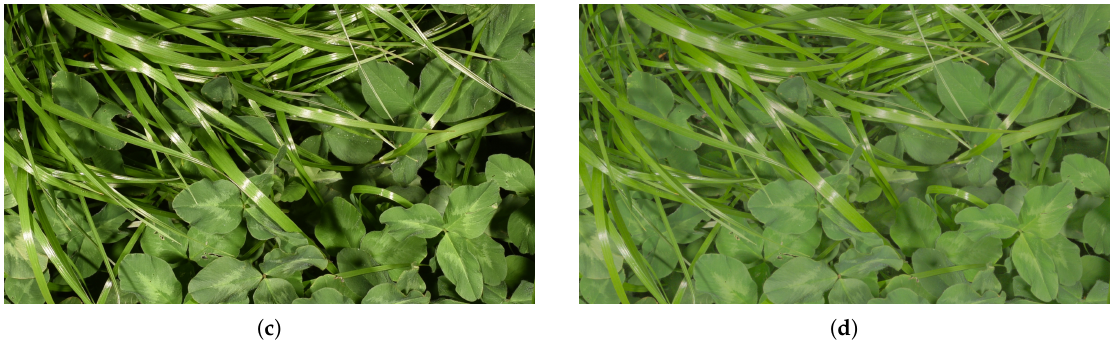
Figure 3. Depiction of the camera setup used for the sample acquisition and visualization of the gamma correction used to reduce the impact of shadow regions. ( a ) The pushcart with the camera system mounted on top; ( b ) Sample of acquired image; ( c ) Crop of an original captured image to illustrate the level of details; ( d ) Gamma-corrected version of ( c ) with a more uniform lighting and increased